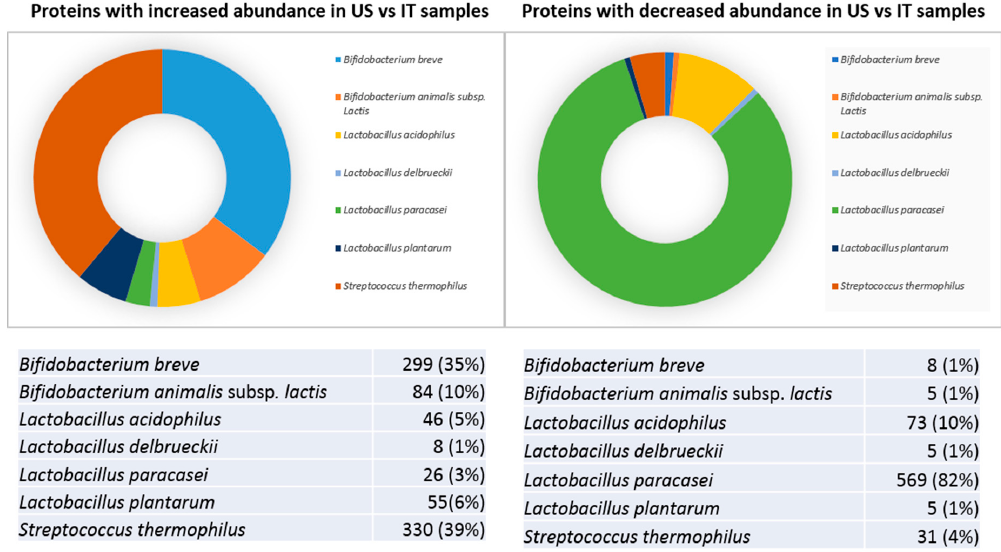
Figure 3. Proteomic representation of different strains in proteins with increased ( A ) or decreased ( B ) abundance in US vs. IT samples.